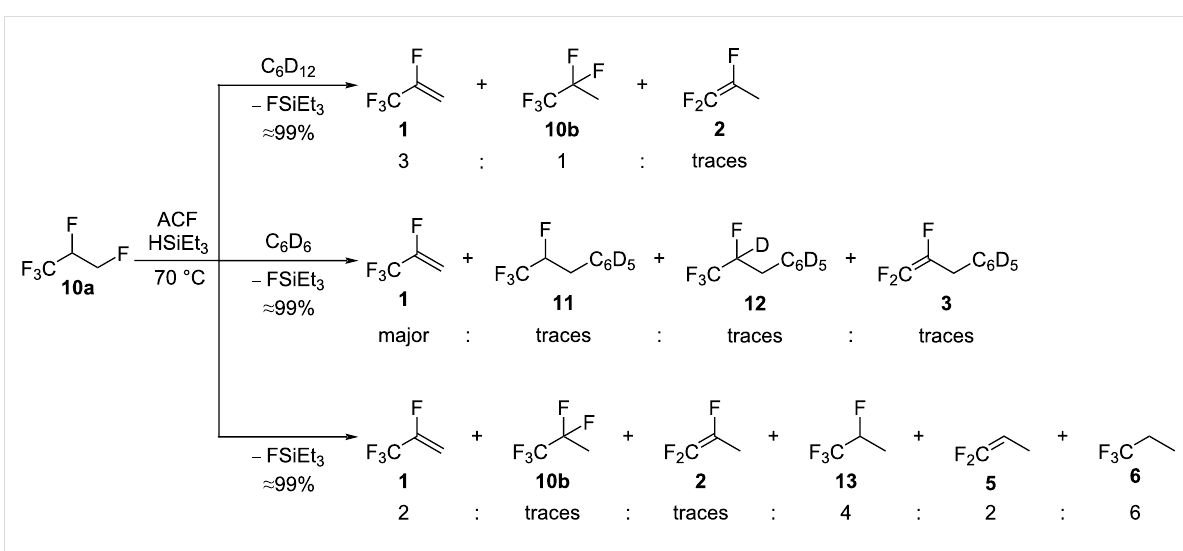
Scheme 4: Reactivity of 10a in the presence of ACF as the catalyst and HSiEt 3 as a hydrogen source in C 6 D 12 (top) or C 6 D 6 (middle) as solvents or in neat silane